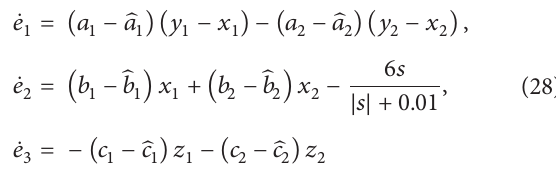
Figure 3: Typical dynamical behavior of hyperchaotic L¨u system. (a) Projection in (𝑥,𝑦, 𝑧) space; (b) projection in (𝑥,𝑦, 𝑤) space; (c) projection in (𝑤,𝑥, 𝑧) space; (d) projection in (𝑦,𝑧,𝑤) space. ̂𝑏 ̂𝑐 where ̂𝑎 𝑗 , 𝑗 , and 𝑗 are the estimates of respectively, 𝑗 = 1, 2 . Choosing the update parameters law